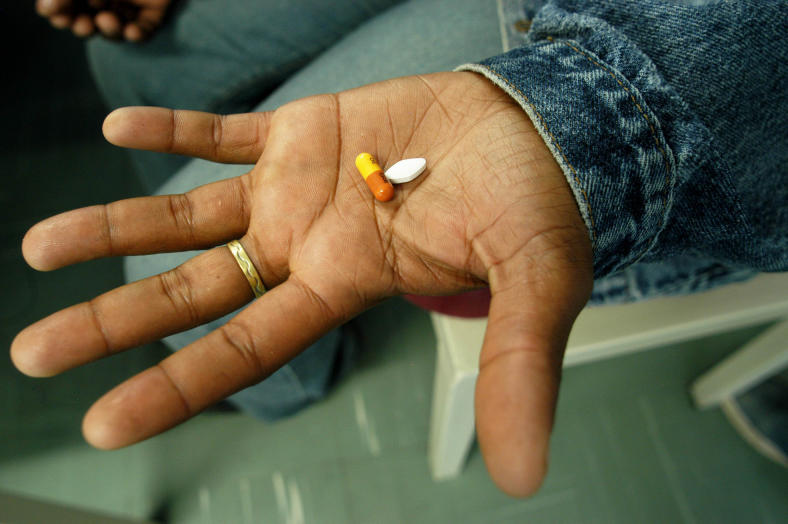
Antiretroviral drugs are unaffordable to most patients in Africa (Photo: Copyright WHO/Eric Miller)]